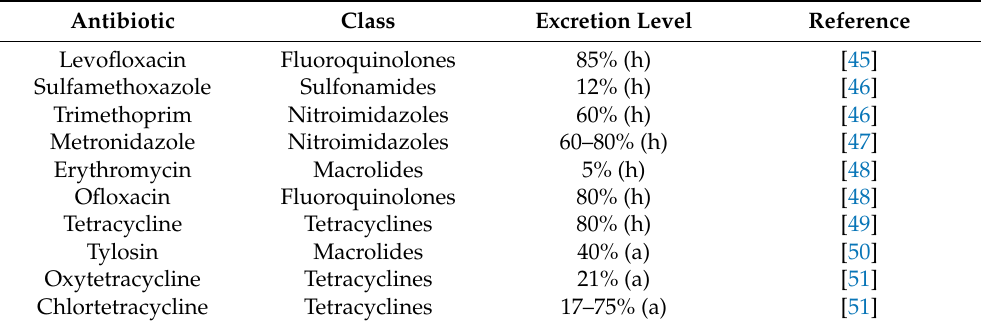
Table 1. Levels of antibiotics excreted in unchanged form after administration to humans (h) or animals